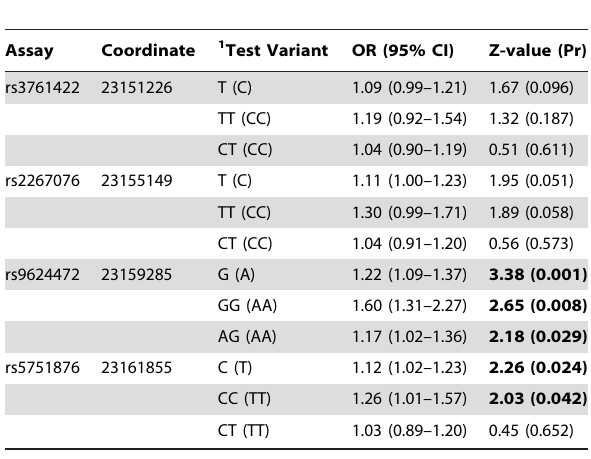
Table 2. Summary of pooled single-locus associations observed in the ADORA2A gene.